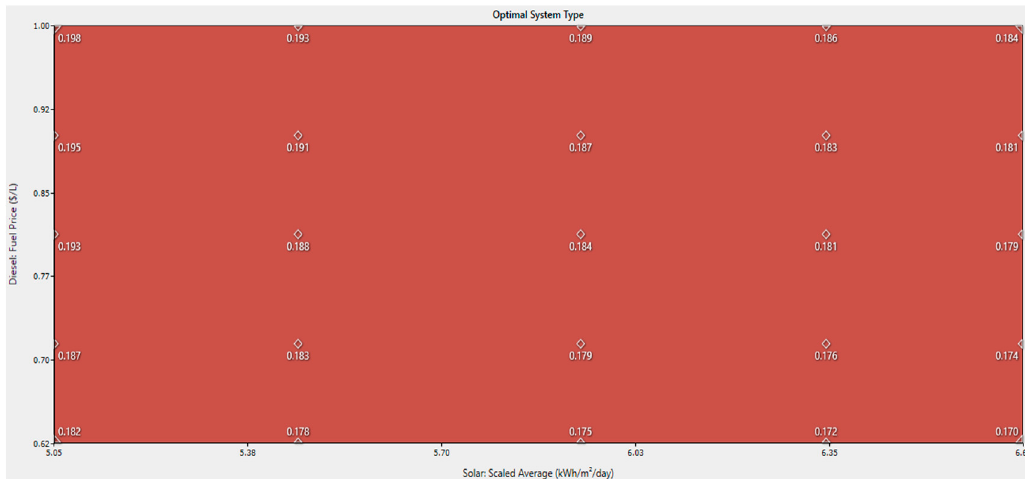
Figure 15. PV/diesel/battery system sensitivity with GHI and diesel price variations.